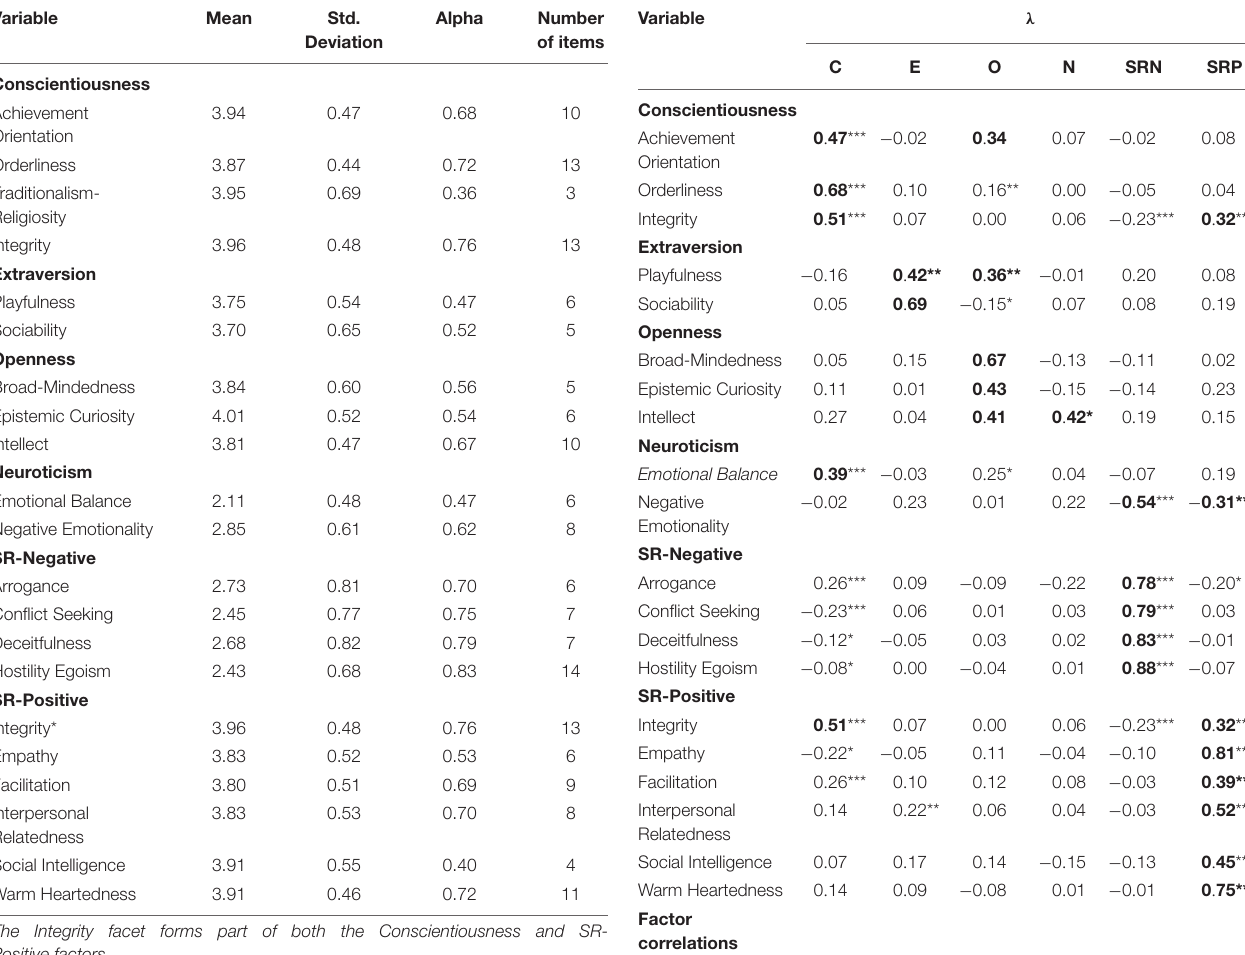
TABLE 6 | Descriptive statistics of the SAPI-SS facets. TABLE 7 | Standardized estimates of the SAPI-SS based on the ESEM